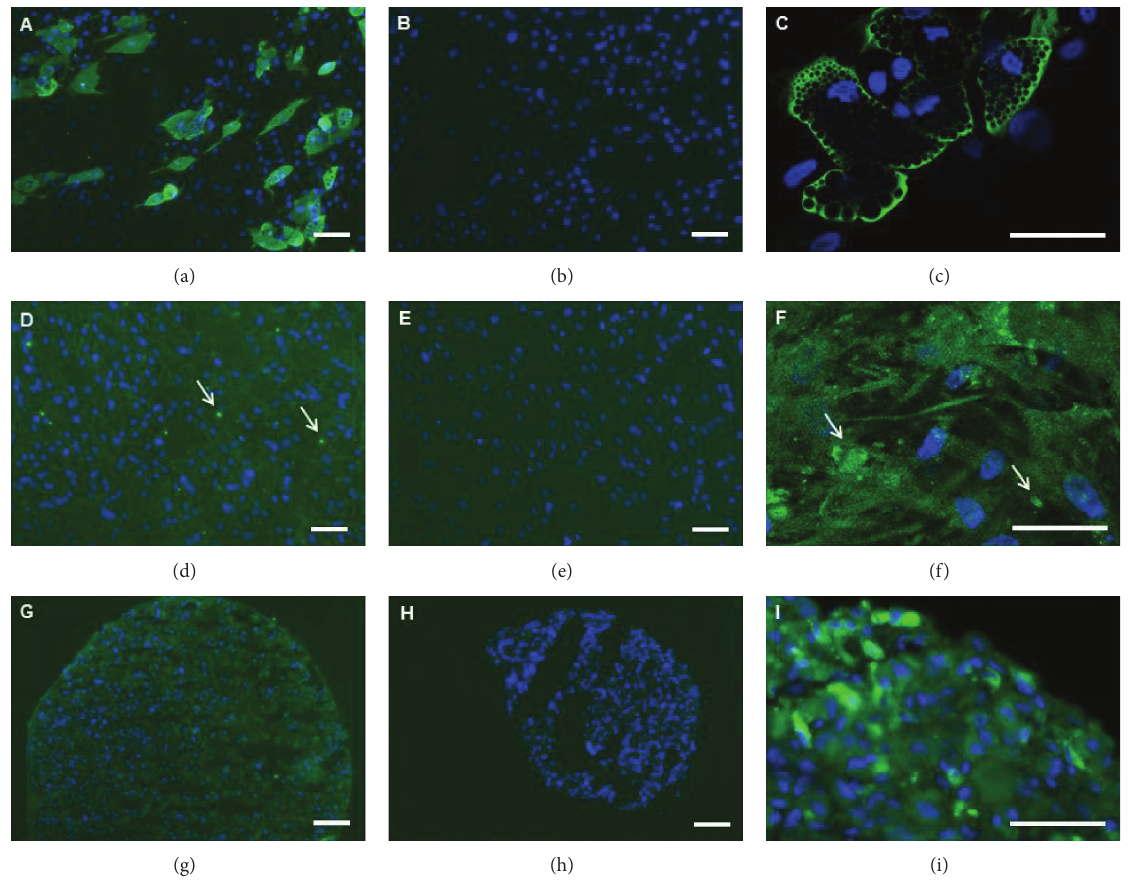
Figure 4: Microscopic characterization of differentiated hMSCs. Phenotypes of hMSCs after 21 days in adipogenic (a)–(c), osteogenic (d)–(f), and chondrogenic (g)–(i) differentiation culture. Images of unstained cells (b), (e), and (h) and images of immunocytochemically stained differentiated cells (a), (c), (d), (f), (g), and (i). Green color displays lineage specific proteins. Adipogenic commitment is shown by staining against fatty acid binding protein-4 (a) and (c), osteogenic commitment by antiosteocalcin staining (d) and (f), and chondrogenic differentiation by staining against aggrecan (g) and (i). Nuclei were counterstained with DAPI (blue). Pictures (b), (e), and (h) show negative controls (secondary antibody only). Arrows (d), (f) indicate accumulations of osteocalcin. These representative pictures have been taken at 100x ((a), (b), (d), (e), (g), (h), scale bar length = 100 𝜇 m) and 400x ((c), (f), (i), scale bar length = 50 𝜇 m)